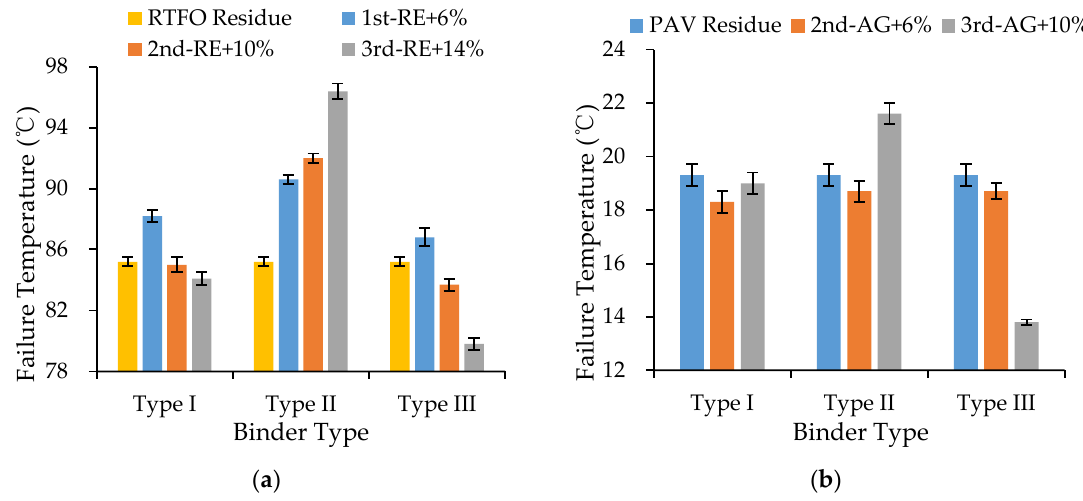
Figure 6. Failure temperature of SBS asphalt-binders at different aging and rejuvenation cycles: ( a ) High-temperature continuous grade; ( b ) intermediate-temperature continuous grade.